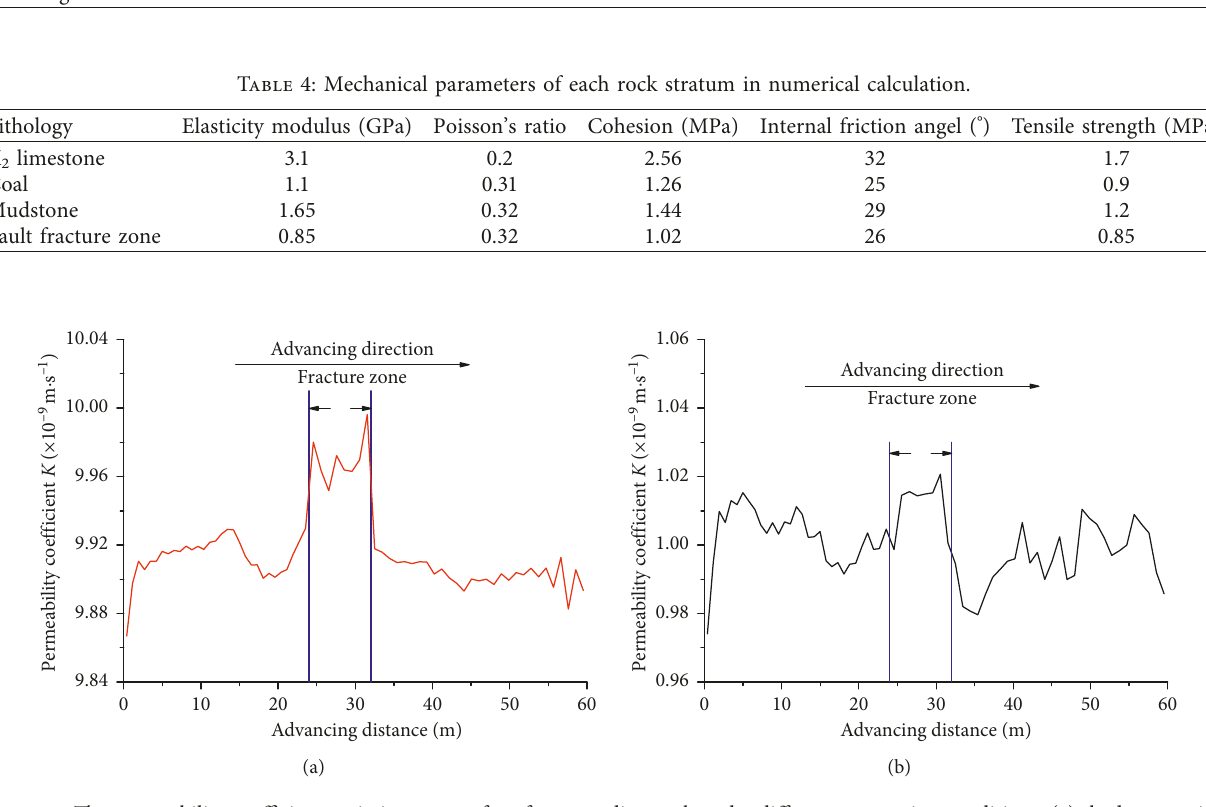
Figure 5: The permeability coefficient variation curve of roof surrounding rock under different supporting conditions: (a) shed supporting condition and (b) bolt-grouting supporting